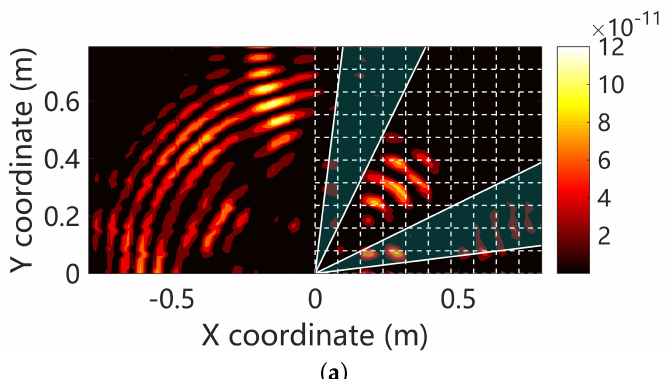
Figure 20. Summaries of the forced response results at 1300Hz: ( a ) the time-history of the element kinetic energies at the monitor points with propagation angle θ = 79 ◦ and θ = π /4 in the piezoelectric composite; ( b ) The angular distribution of the instantaneous element kinetic energy at the monitor points; ( c ) The distribution of the instantaneous kinetic energy of the whole structure (only the upper half is shown due to symmetry). In Figure 20b,c, the results are obtained at the same time point t = 2.6 × 10 − 3 s marked by the dotted line in Figure 20a, and the identified band gap angles are highlighted by the grey areas.